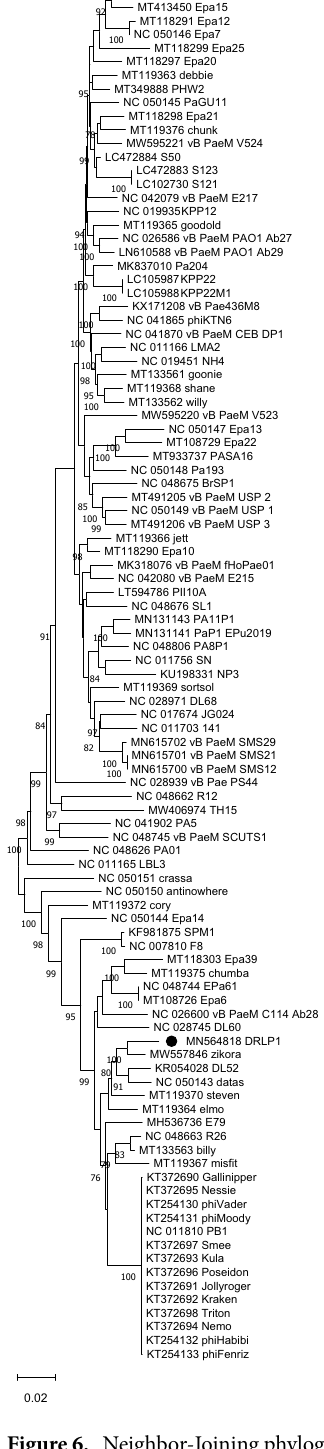
Figure 6. Neighbor-Joining phylogenetic tree based on complete genome sequences from DRL-P1 and related 100 GenBank sequences. Multiple sequences were aligned using the MAFFT online server. Evolutionary distances were calculated using the Maximum Composite Likelihood method implemented in MEGA X computer program. Numbers below the branches represent percentage of replicate trees, where the associated taxa clustered together during the bootstrap test (1000 replicates). The optimal tree is drawn to scale with branch lengths signifying the evolutionary distances used to infer the tree. A total of 147,417 positions were available in the final dataset for evolutionary analyses. Ambiguous positions were excluded from analysis. Graphical presentation of the phylogeny was generated using the MEGA X computer program, version 10.2.4 (https:// www. megas oftwa re.